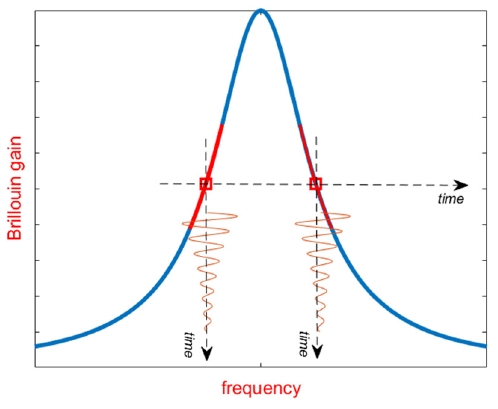
Figure 14. In the dual slope-assisted BOTDA method, the probe frequency is switched between the two slopes, while the dynamic strain is extracted from the ratio between the signals acquired from the two slopes [61].